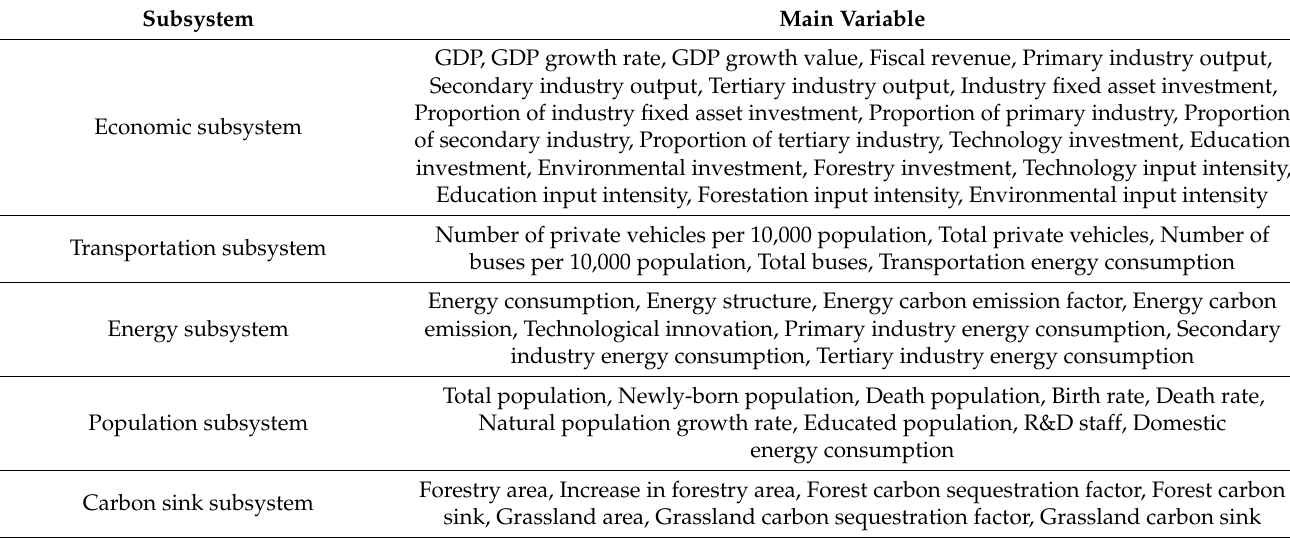
Table 2. Subsystems and main